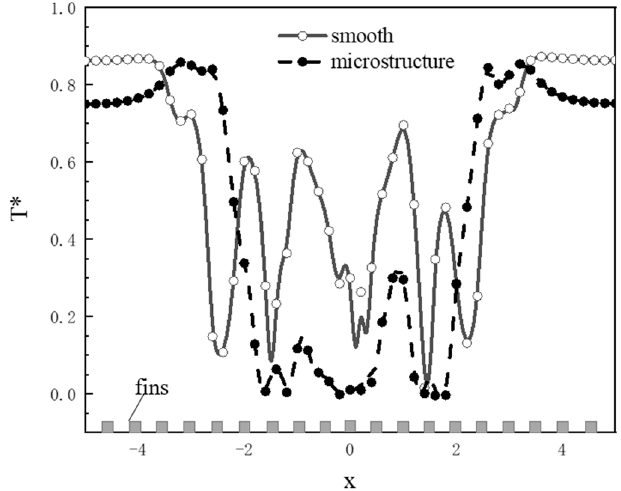
Figure 19. Temperature distribution at the smooth and micro-structured surfaces ( t * = 5).